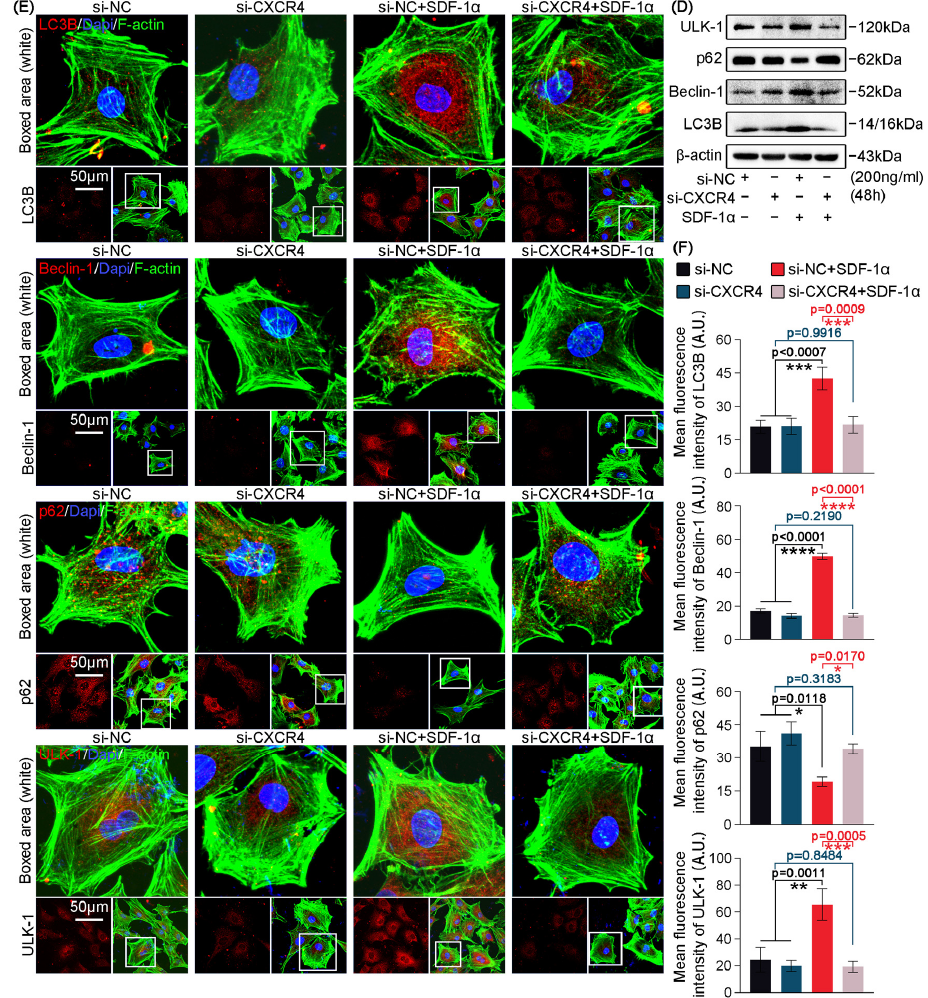
Figure 3. SDF-1 α regulates autophagy of chondrocytes through CXCR4. ( A ) mRFP-GFP-LC3 ade- novirus double label assay indicating that CXCR4 silencing inhibited the increase of autophagy flux in chondrocytes induced by SDF-1 α (200 ng/mL) for 48 h. Free red dots represent autolysosomes. Yellow dots represent autophagosomes. White arrows point to the autolysosome. We counted three cells from three independent experiments in each group to detect the changes in the levels of autophagy. ( B ) Quantitative analysis of the number of mRFP and GFP dots in chondrocytes shown in ( A ). ( C ) Quantitative analysis of the number of autophagosomes and autolysosomes in chondrocytes shown in ( A ). ( D ) Representative western blots showing that si-CXCR4 inhibited the expression changes of autophagy-related proteins (ULK-1, p62, Beclin-1 and LC3B) induced by SDF-1 α (200 ng/mL) for 48 h. ( E ) Representative immunofluorescent images demonstrating that the expression changes of autophagy-related proteins (ULK-1, p62, Beclin-1, LC3B) induced by SDF-1 α (200 ng/mL) for 48 h were inhibited in chondrocytes after CXCR4 silencing. Cytoskeleton (F-actin), green; Nucleus (Dapi), blue ( F ) Quantitative analysis of the mean fluorescence intensity of ULK-1, p62, Beclin-1 and LC3B in chondrocytes shown in ( E ). We counted 15 cells per group from three inde- pendent experiments to show the changes in the expression and distribution of autophagy-related proteins. The data shown in ( A , D , E ) are based on three independent experiments ( n = 3). Data in ( B , C , F ) are presented as the mean ± SD, and the significance is based on two-tailed Student’s t -tests. ns: no statistical significance; * p < 0.05; ** p < 0.01; *** p < 0.001; **** p <